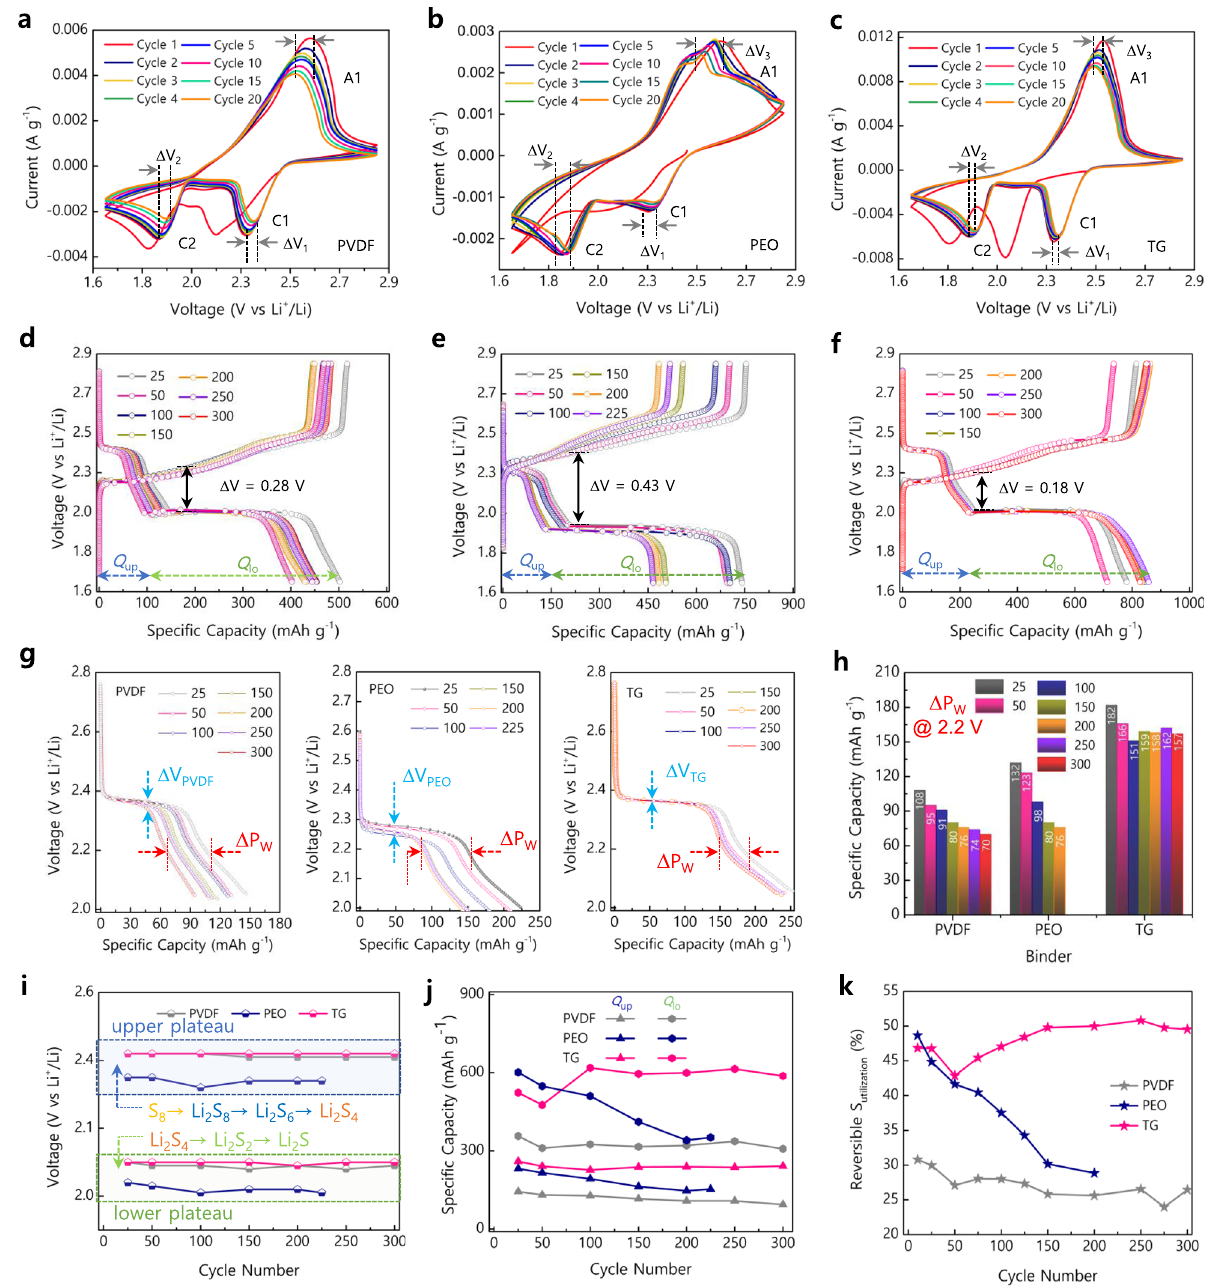
Fig. 2 Improved electrokinetic properties of S/TG compared with S/PVDF and S/PEO cathodes. a – c Cyclic voltammetry (CV) curves recorded at a scan rate of 1 mV s – 1 . d – f Discharge-charge pro fi les at a current rate of 1 C (1.675 Ah g – 1 ). g Onset potential at different cycles extracted from d – f . h Corresponding capacity observed at 2.2 V. i Onset potential denoting the reduction of sulfur in the upper and lower plateau regions during cycling at 1 C. j Capacity fade and retention at the respective upper potential ( Q up ) and lower potential ( Q lo ) extracted from d – f . k Reversible sulfur utilization of various electrodes shown for selected cycle reversible and stable capacity of the S/TG electrode is exclusively (Fig. 2d – g). From the typical voltage pro fi le, the discharge curve achievable only in conjunction with the lower resistance of the represents a multistep sulfur reduction to Li 2 S upon accepting Li- ions and electrons as apparent through the plateaus at high and electrode constituents (Figs. 1e, 2f). To substantiate this claim, low voltage regions 6,7 . In Fig. 2d – f, the range to which the the voltage polarization ( Δ V) taken as a measure of resistance discharge pro fi le extends and remains stable exposes the higher exerted during the discharge-charge cycle was found to be higher deliverable capacity and superiority of S/TG among S/PVDF and for S/PEO and S/PVDF electrodes as 0.43 and 0.28 V, S/PEO electrodes. In such a case, the S/TG electrodes exhibited a respectively (Fig. 2d, e). In comparison, S/TG showed a lower high discharge/charge capacity of 829/856 mAh g − 1 at the end of polarization of 0.18 V due to nominal resistance that provides the 300th cycle, which is attributed to an ef fi cient sulfur good stability and integrity of electrode particles by the TG reduction and utilization. It is worth mentioning that the highly binder (Fig. 2f).